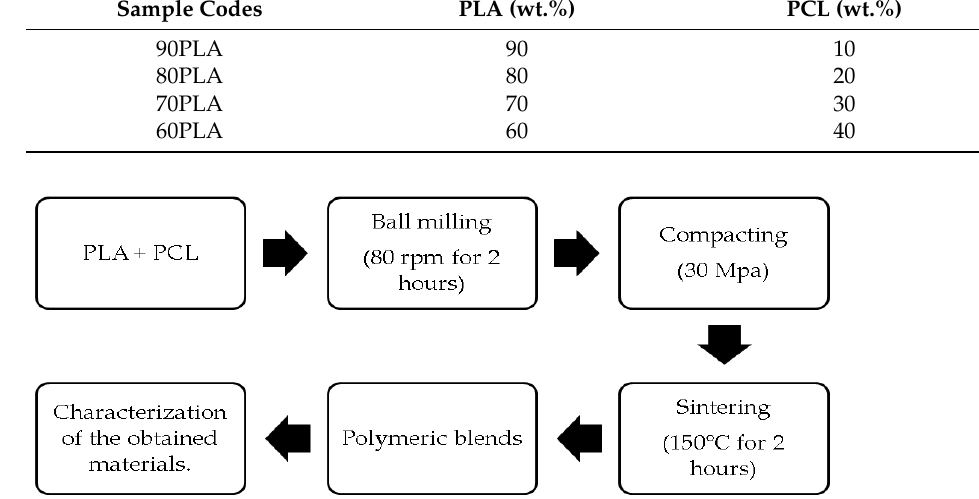
Figure 1. The preparation process of PLA/PCL blend.